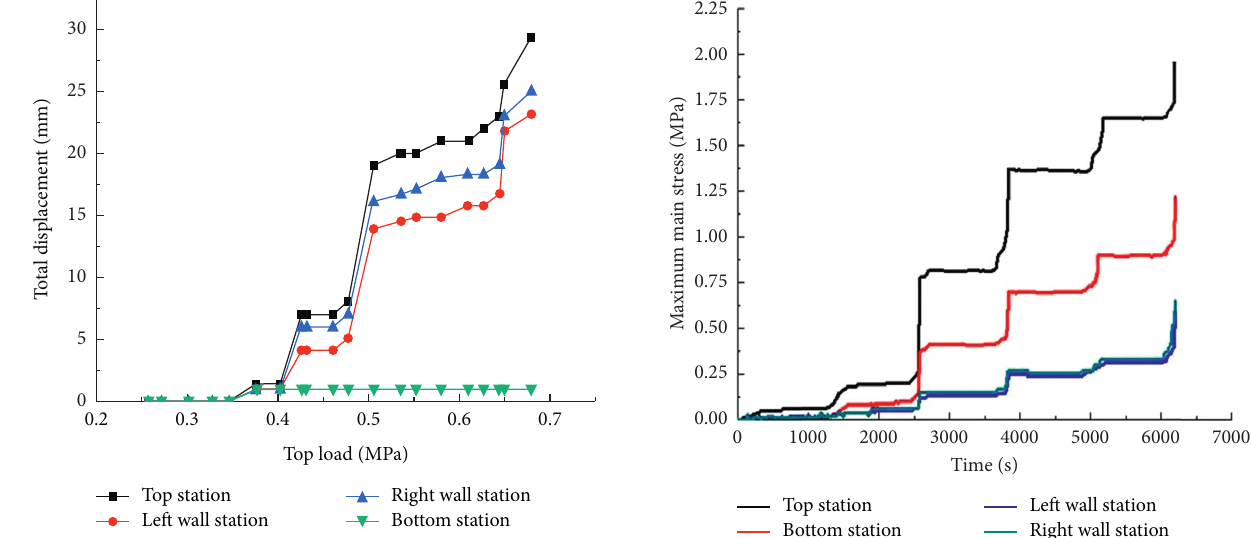
Figure 22: Maximum principal stress curve of supporting